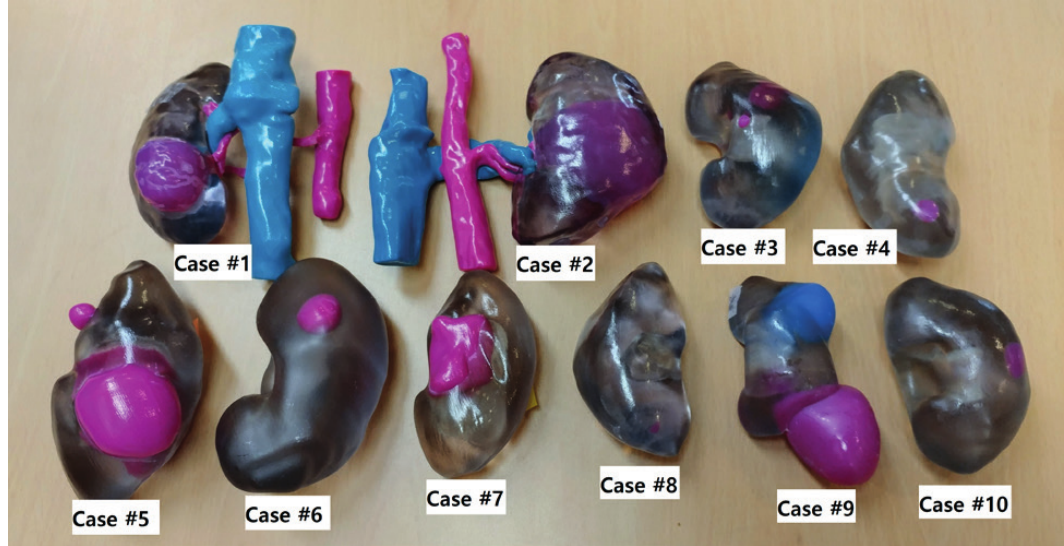
figure 2 - The produced 3D renal models for